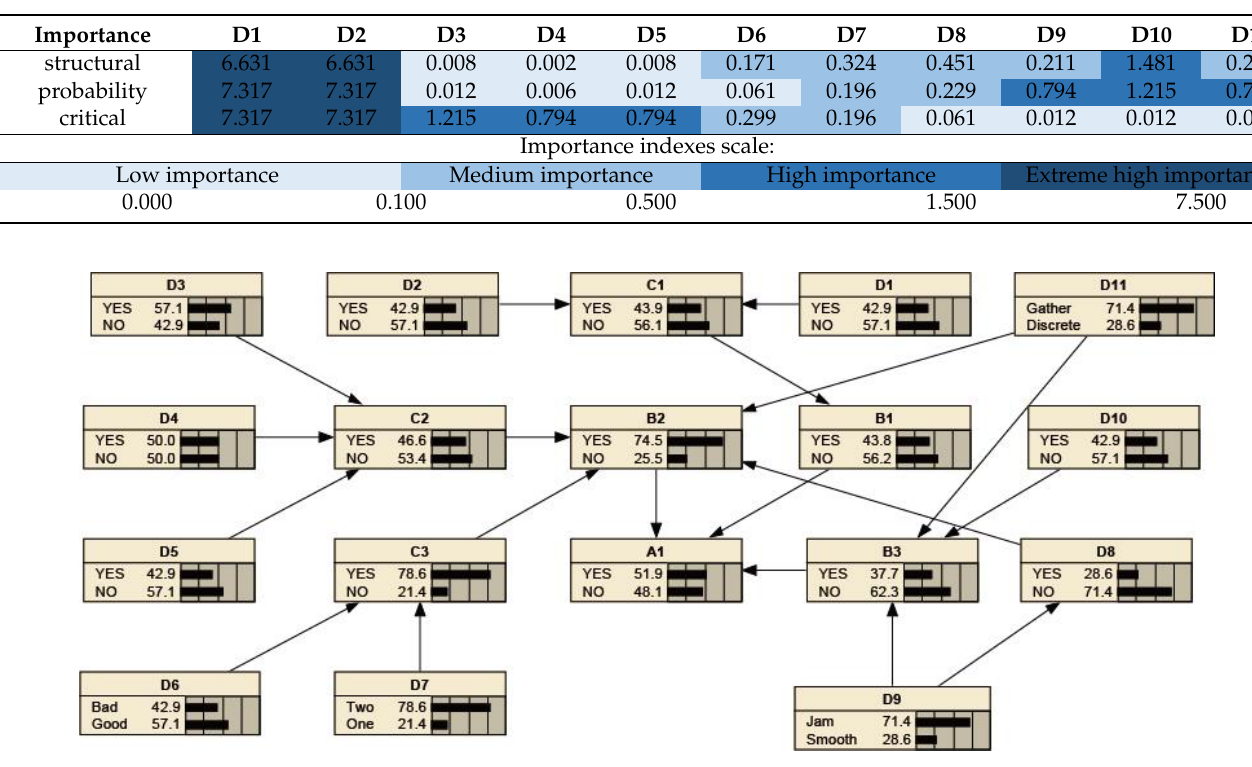
Figure 7. Netica-Bayes topology network weight calculation result.